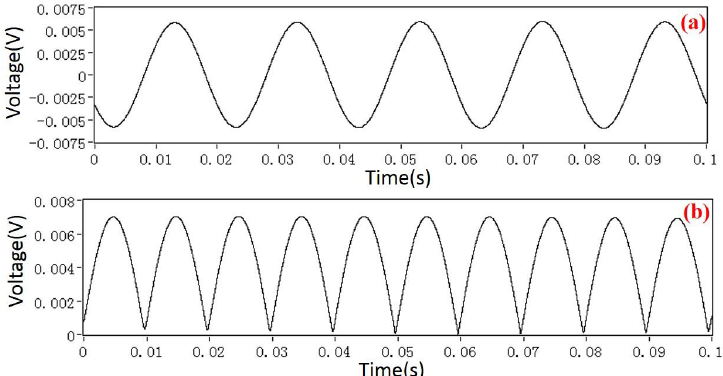
Figure 13. Demodulation results of a 50 Hz power frequency field using the HOCBM: ( a ) The output of X ( t ); ( b ) The output of R ( t ).